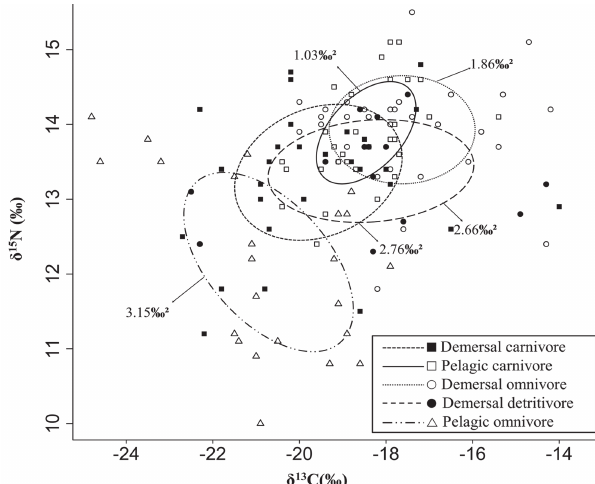
Fig. 3. Isotopic niche areas of the trophic guilds of fish of the lower portion of the rio Paraíba do Sul watershed. Values in ‰ 2 indicate the corrected standard ellipse areas (SEAcs).